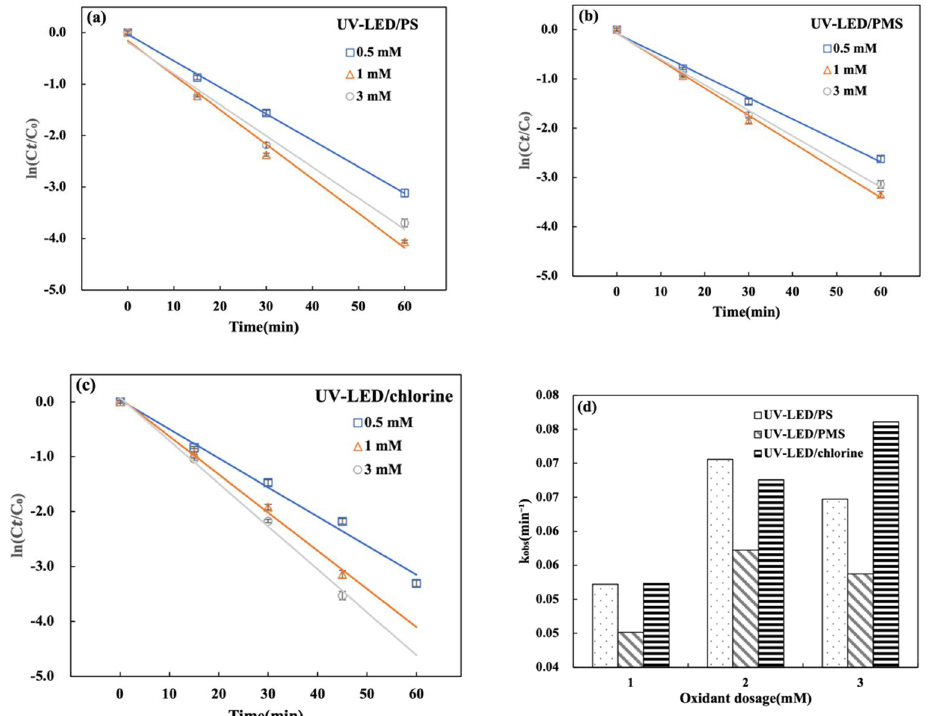
Figure 4. Effect of initial oxidant dosage on CAP degradation during ( a ) UV-LED/PS; ( b ) UV- LED/PMS; ( c ) UV-LED/chlorine processes. ( d ) Comparison of k obs values. Conditions: [CAP] 0 = 5.0 mg/L, lamp power I 0 = 2.4 mW/cm 2 , wavelength = 280 nm, t = 60 min, pH = 7.0.